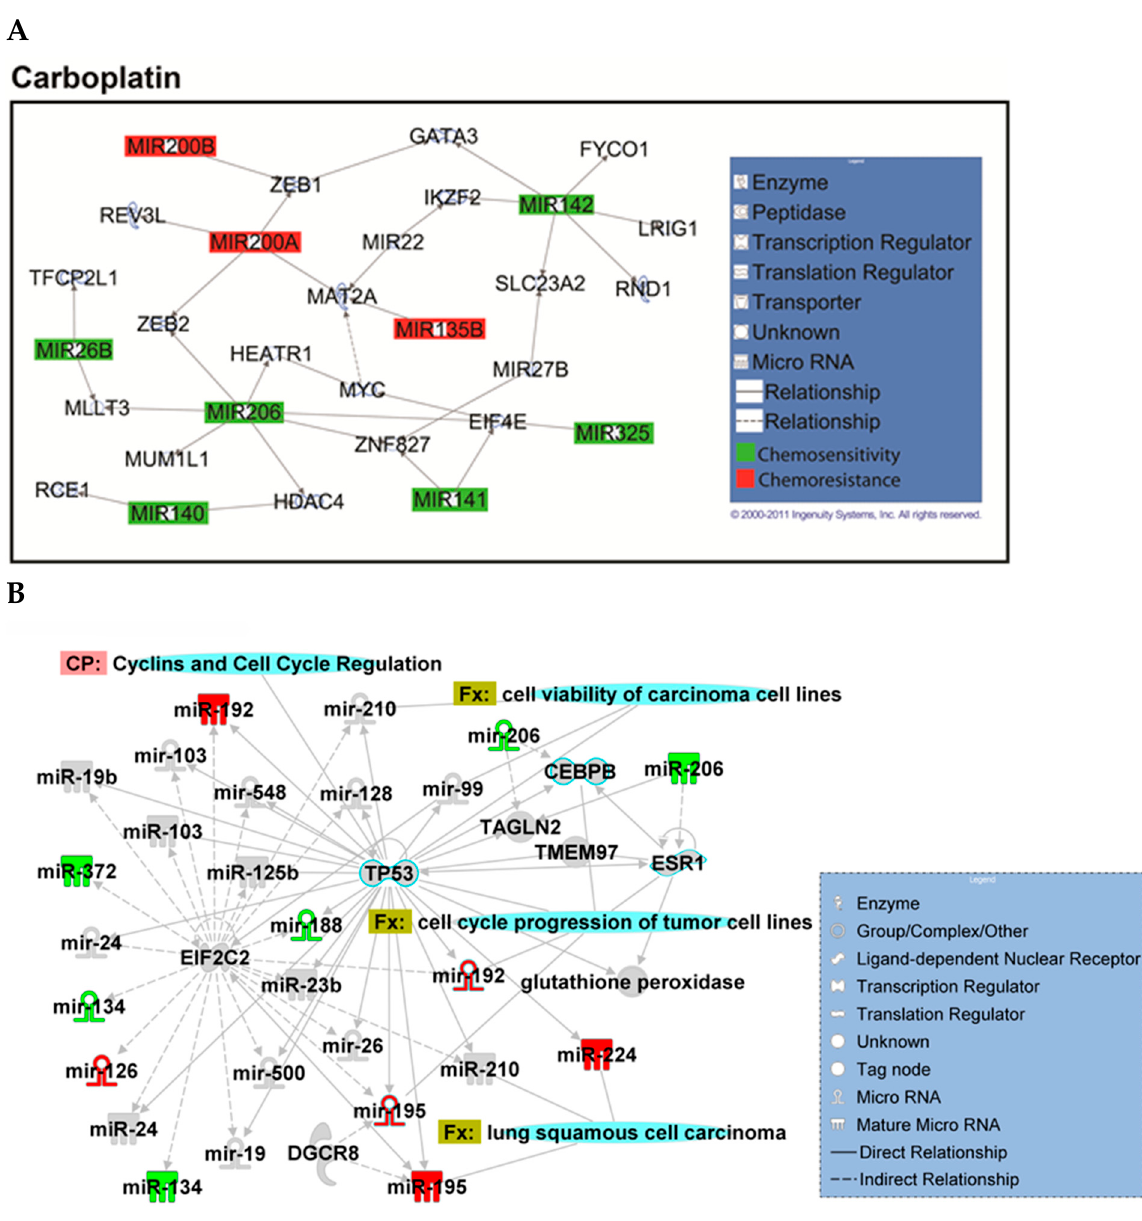
Figure A2. Overview of network derived from IPA Core analysis, representing interactions between miRNAs found to be chemopredictive for carboplatin and genes relevant to the significant functions and diseases listed in Tables 3 and 4. ( A ) miRNAs and their mRNA target genes. ( B ) Involvement of miRNAs in pathways, functions, and diseases. Canonical pathways (CP:) and functions and diseases (Fx:) as defined by IPA are overlaid to highlight the interconnectedness of the set with molecular processes relevant to chemoresponse. Predictive miRNAs whose expression was positively associated with survival are shown in green, and those whose expression was negatively associated are shown in red.